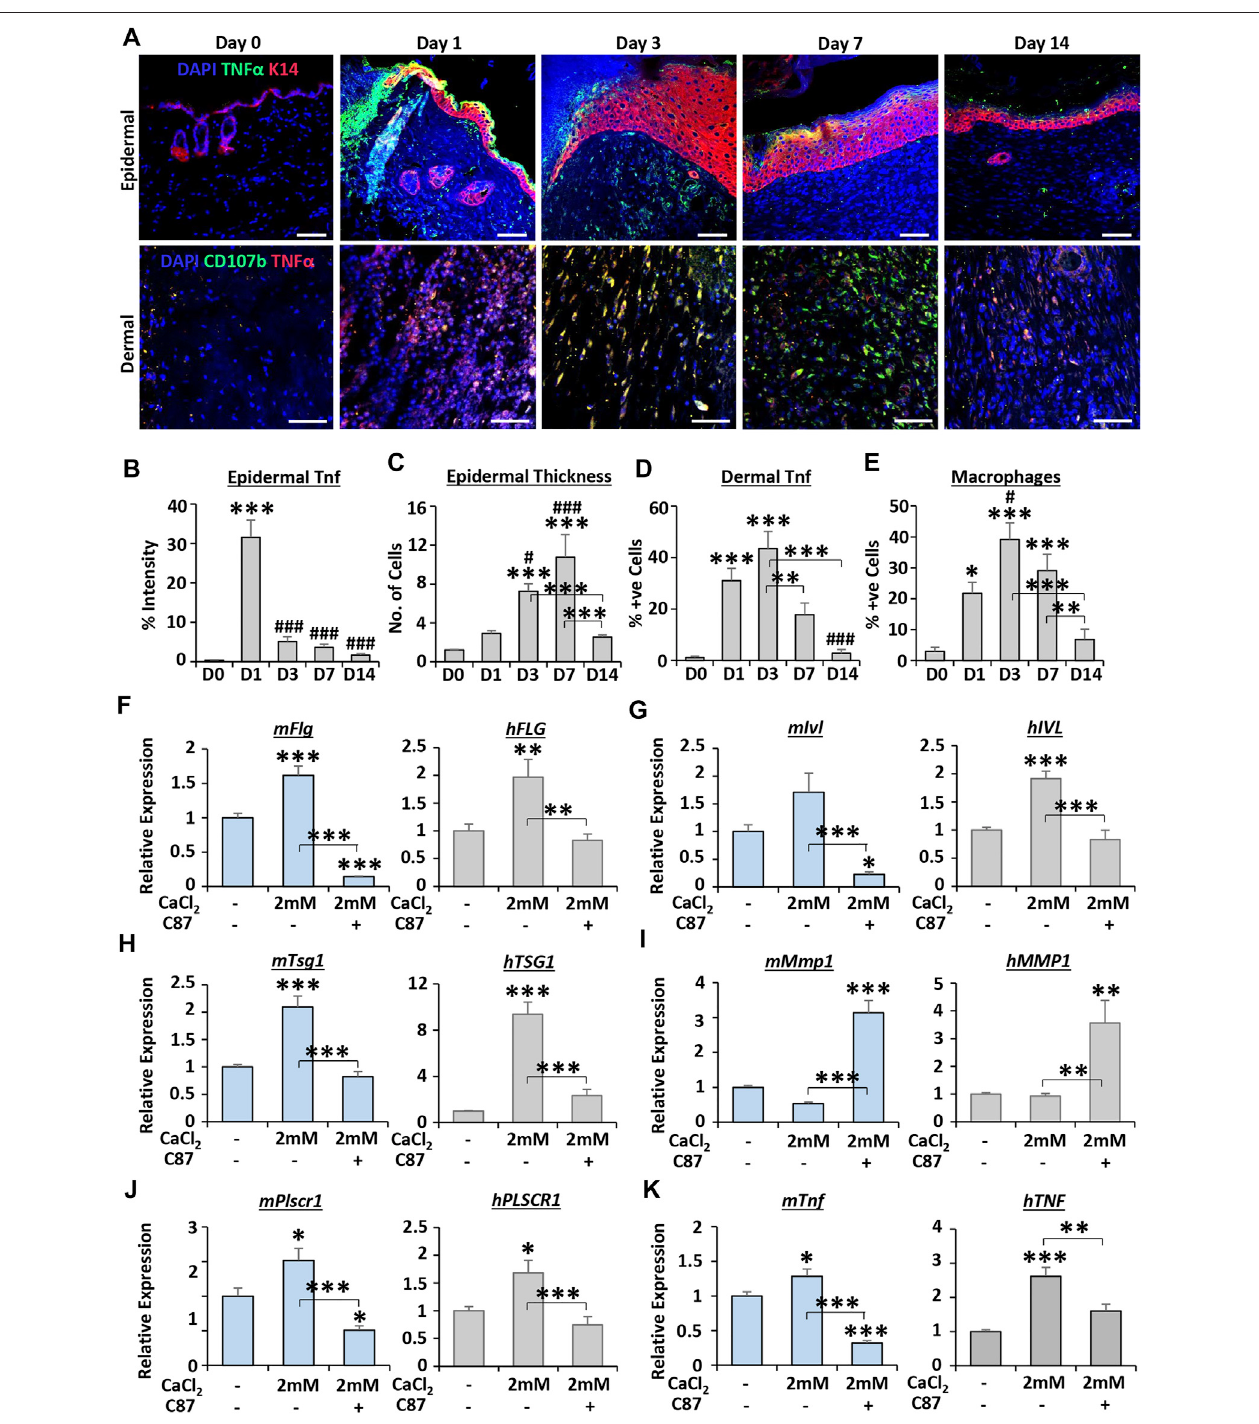
FIGURE 6 | TNF α inhibitor treatment impairs calcium-dependent differentiation in keratinocytes. Mouse epidermal staining for keratin 14 (K14, red) and TNF α (green) and dermal staining for CD107b (green) and TNF α [red; (A) ]. DAPI (cid:2) blue nuclei. Bar (cid:2) 50 µm. Quanti fi cation of epidermal TNF α (B) , epidermal thickness (C) , dermalTNF α (D) andmacrophages[CD107b+ve (E) ]. n (cid:2) 5mice.qRT-PCRfordifferentiationmarkers (F – H) andTNF-linkedmarkers (I – K) inprimarymurineandhuman keratinocytes.C87 (cid:2) TNF α inhibitor. n (cid:2) 3donors.Mean+SEM.One-wayANOVAwithTukey ’ s post-hoc analyseswereperformed.*/# (cid:2) p < 0.05,** (cid:2) p < 0.01and ***/### (cid:2) p < 0.001. Asterisk alone versus D0 or no calcium. Hashtag alone versus D1 in (B – E) .